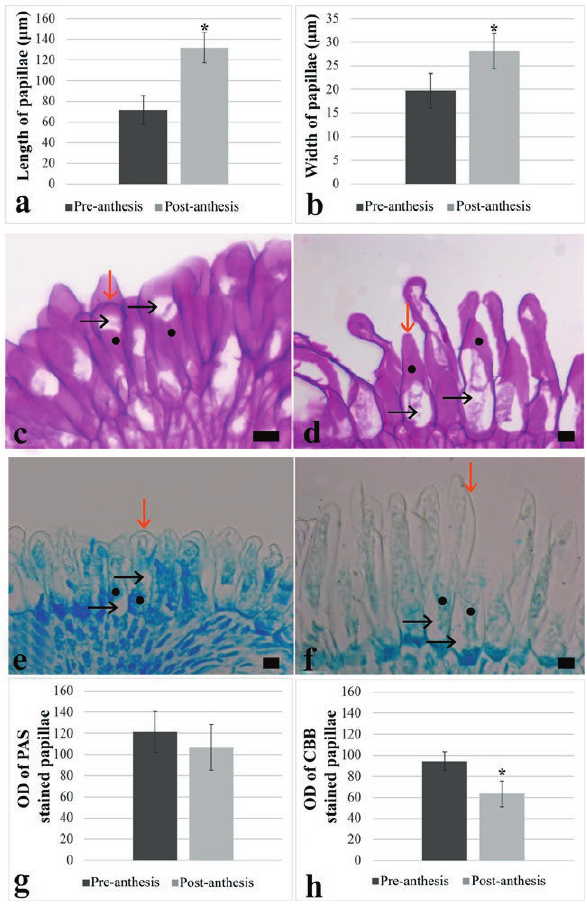
Figure 1. Morphological and biochemical changes of papillae at pre-anthesis and post-anthesis. a Length of papillae. b Width of papillae. c PAS stained papillae at pre-anthesis. d PAS stained papil- lae at post-anthesis. e CBB stained papillae at pre-anthesis. f CBB stained papillae at post-anthesis. g OD of PAS stained papillae. h OD of CBB stained papillae. Black arrows indicate the vacuoles, red arrows indicate the cell wall and points indicate the cytoplasms. Bar: 20